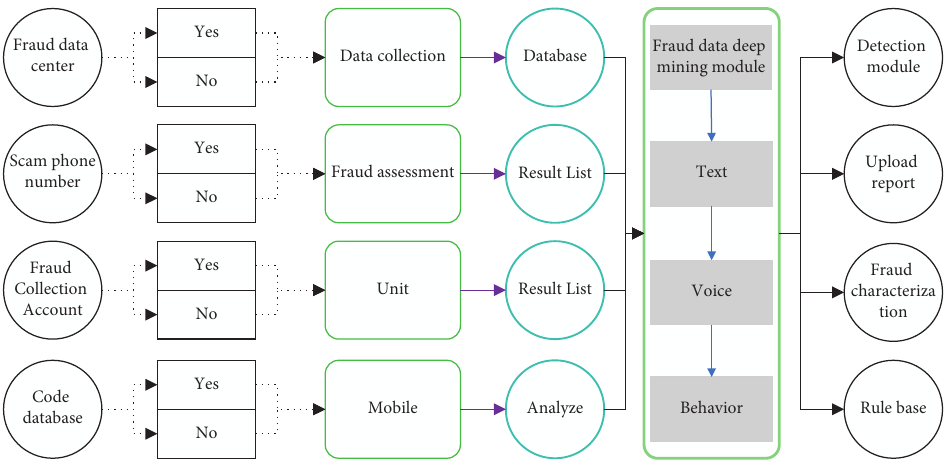
Figure 1: Flow chart of big data analysis of telecom fraud.